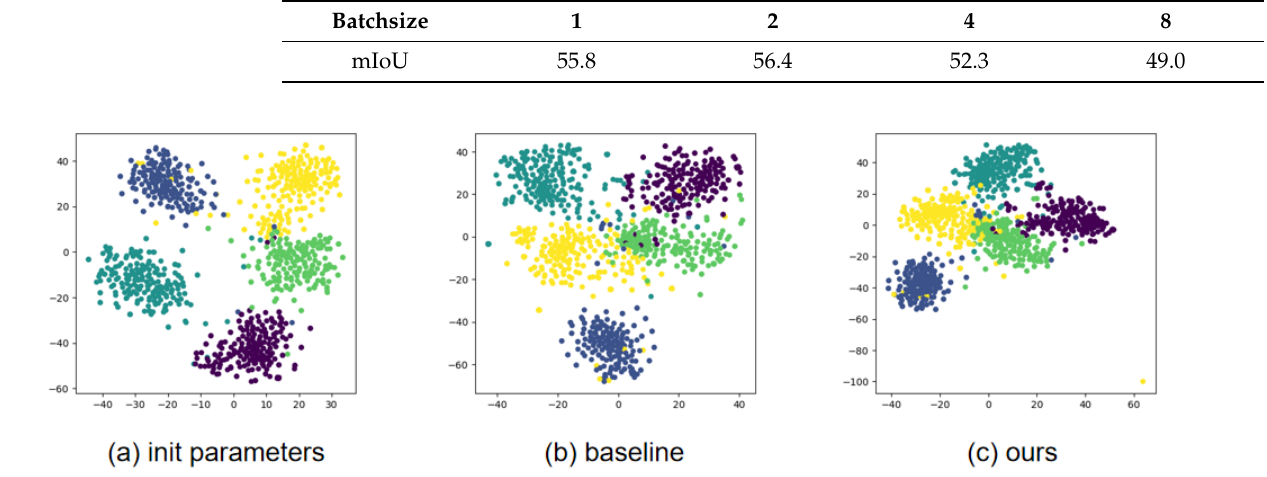
Figure 6. The t-sne visualization of the model and different colors represent features of different categories with and without background learner is shown in the figure.